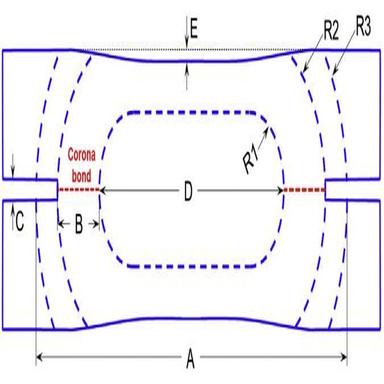
Schematic of a resistance spot weld.